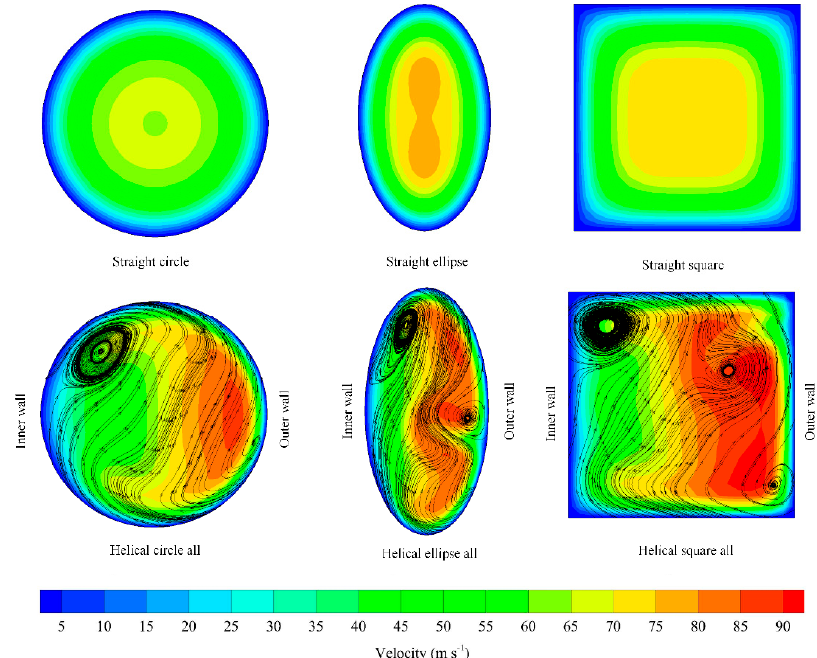
Figure 5. Axial velocity profile (contour, m s − 1 ) and streamlines of flow in ( a ) straight circle, ( b ) straight ellipse, ( c ) straight square, ( d ) helical circle, ( e ) helical ellipse, and ( f ) helical square tubes at L = 31 mm and Reynolds number of 1000.